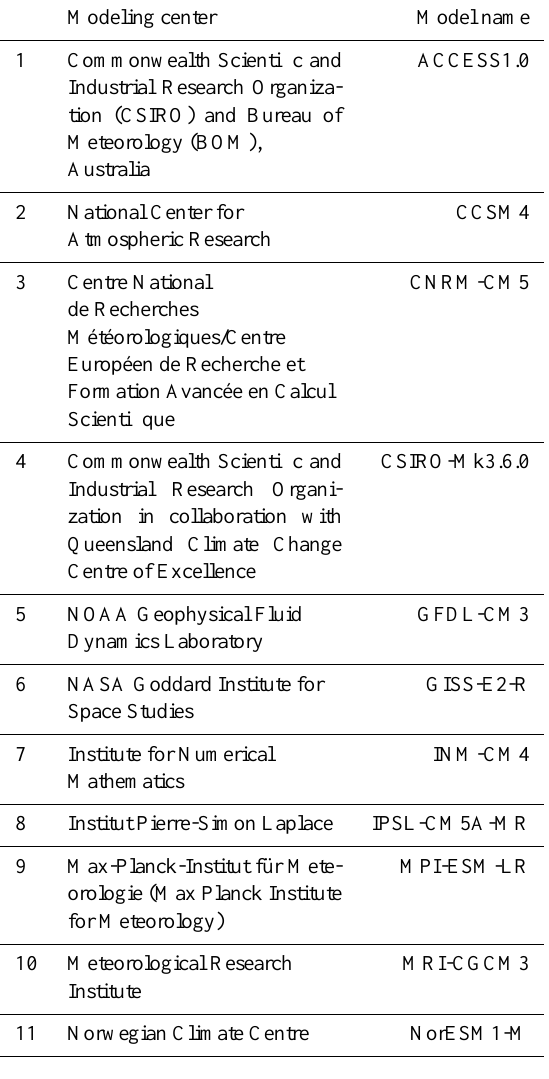
Table A1. Climate models used in this